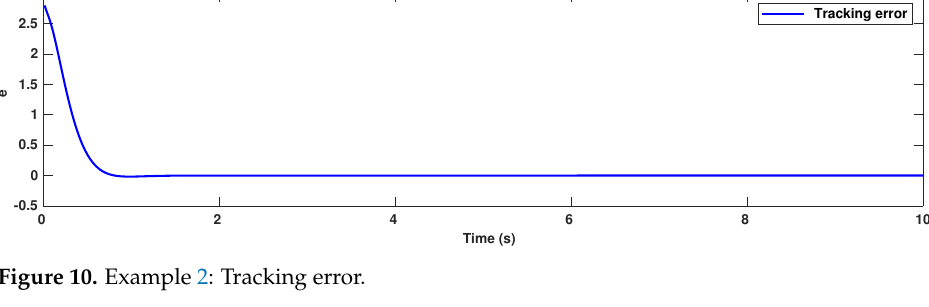
Figure 10. Example 2: Tracking error.